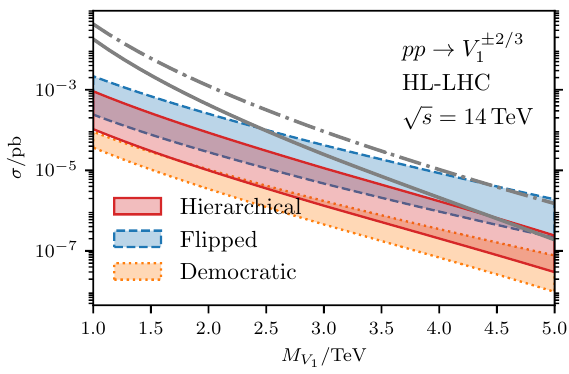
Figure 6 . Resonant leptoquark production cross section from lepton-quark fusion for the flavor scenarios (2.9), (2.11), (2.12) at the HL-LHC. The solid (dash-dotted) grey line indicates the reso- nant cross section with only the bµ ( sµ ) coupling set to